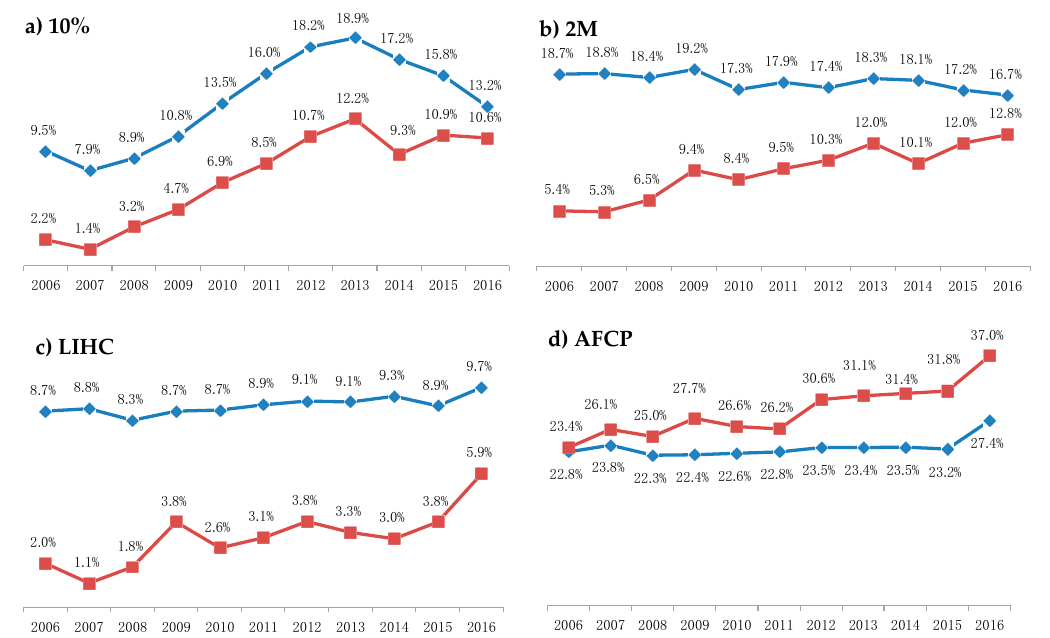
Figure 6. Trend of income-based indicators in Spain (blue line) and the Canary Islands (red line): ( a ) 10%; ( b ) 2M; ( c ) LIHC; and ( d ) AFCP.